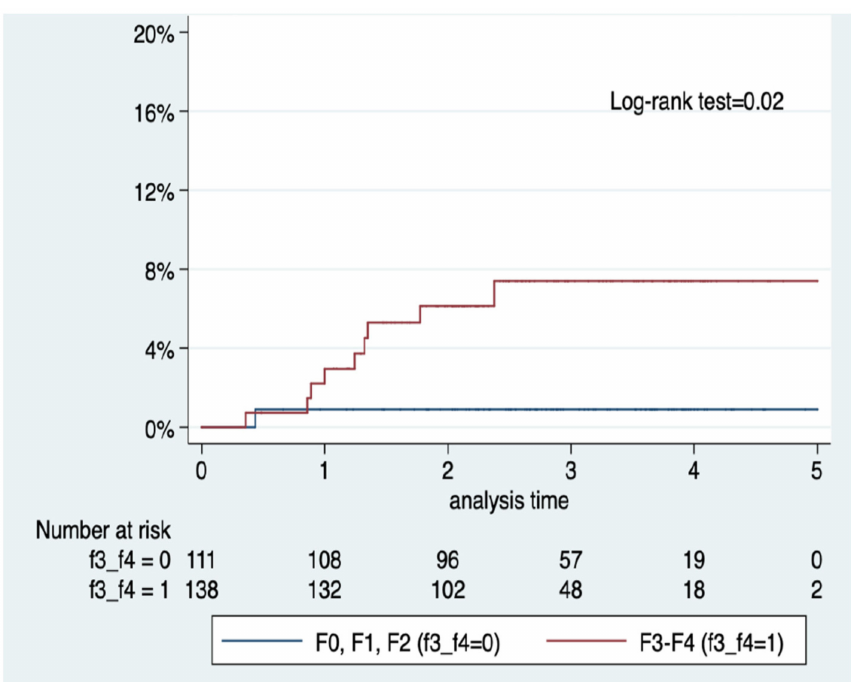
Figure 3. Kaplan–Meier survival curves for hepatocellular carcinoma incidence according to the presence of advanced fibrosis (F3–F4) in liver biopsy ( n = 249).